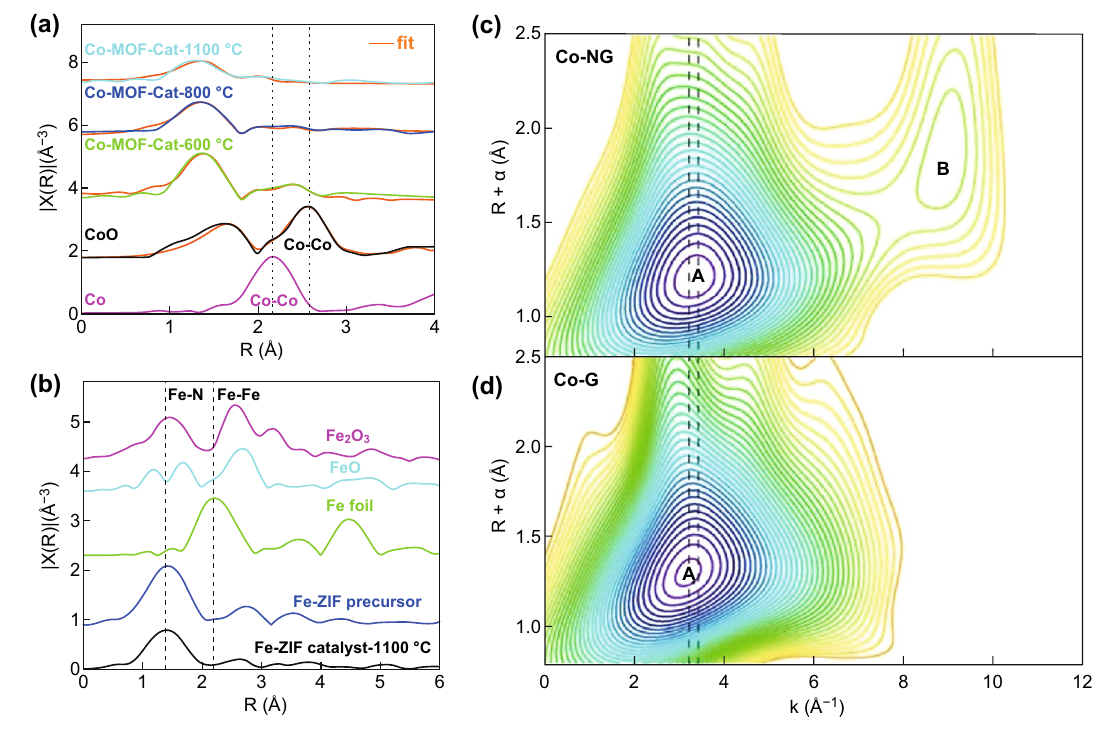
Fig. 7 a Co K-edge EXAFS data and fits (orange). Reprinted with permission from Ref. [73]. b Fe K-edge EXAFS spectra for chemically Fe- doped ZIF before and after thermal activation. Reprinted with permission from Ref. [74]. Wavelet transforms for the c Co–NG and d Co–G. The location of the maximum A shifts from 3.2 Å −1 for Co–G to 3.4 Å −1 for Co–NG, indicating the presence of Co–N bonding in Co–NG. The verti- cal dashed lines are provided to guide the eye. Reprinted with permission from Ref.